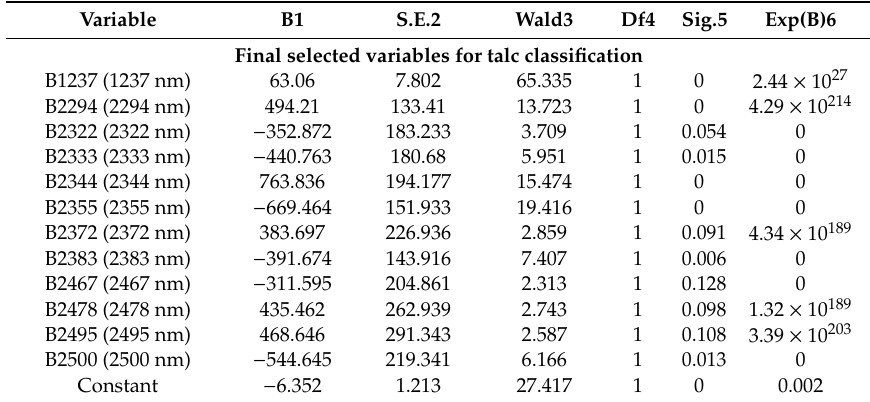
Table 8. An accuracy table for the classification results derived from binary logistic regression models.